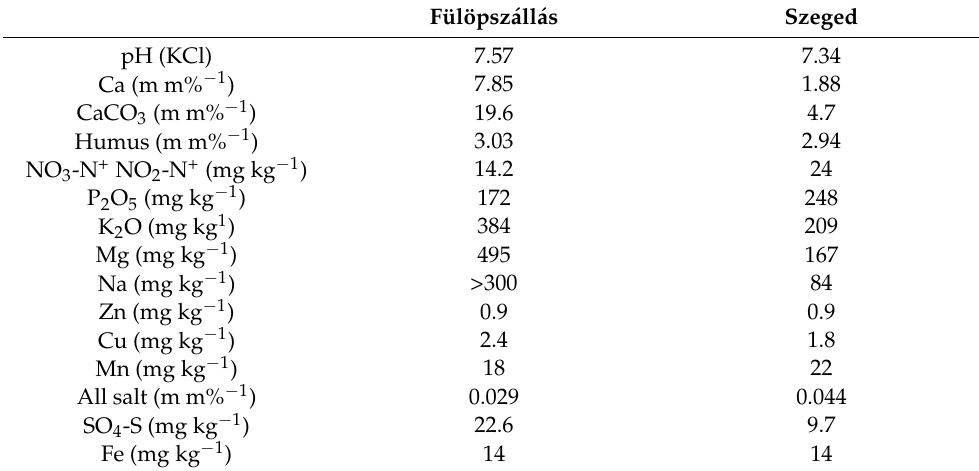
Table A2. Soil characteristic of experimental sites.